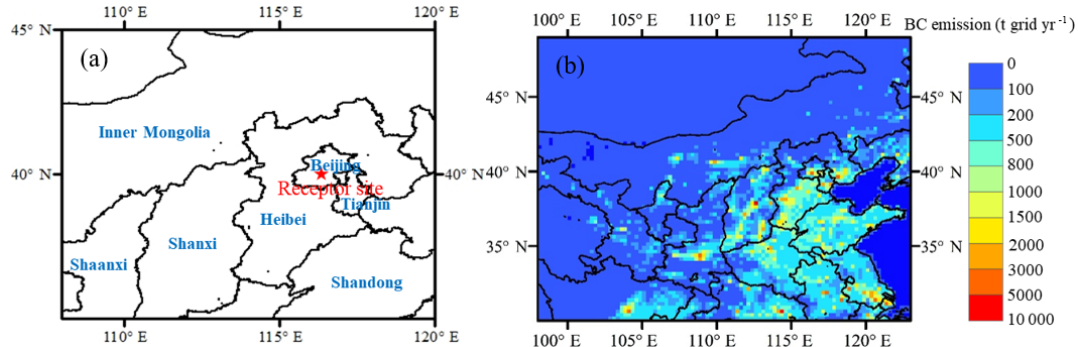
Figure 2. (a) The location of the receptor site (Tsinghua site (40 ◦ 00 (cid:48) 17 (cid:48)(cid:48) N, 116 ◦ 19 (cid:48) 34 (cid:48)(cid:48) E), marked as a red star) during the BJNOV2014 measurement period. (b) Spatial distribution (0 . 25 ◦ × 0 . 25 ◦ ) of the BC emission inventory from